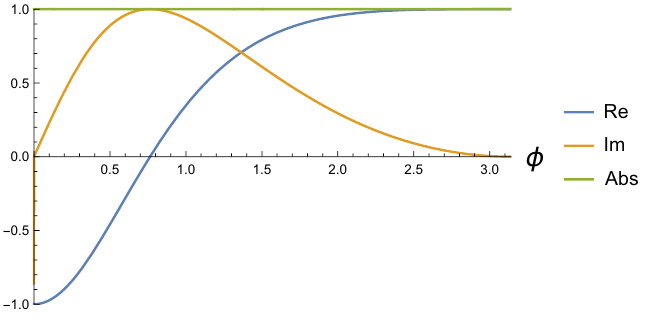
Figure 4 . The real part, the imaginary part and the absolute value of the partial amplitude for the scattering of the lightest asymptotic state with m 1 = 1 given the mass of the second asymptotic state m 2 = p 3 and the value of the trilinear coupling (5.21). The plot is constructed with N max = 50. charge and the corresponding partial amplitude and the form factor are precisely the ones of the sine-Gordon model. The bound on the central charge around m 2 central charges at two extremes of (cid:12)gure 7, namely at m 2